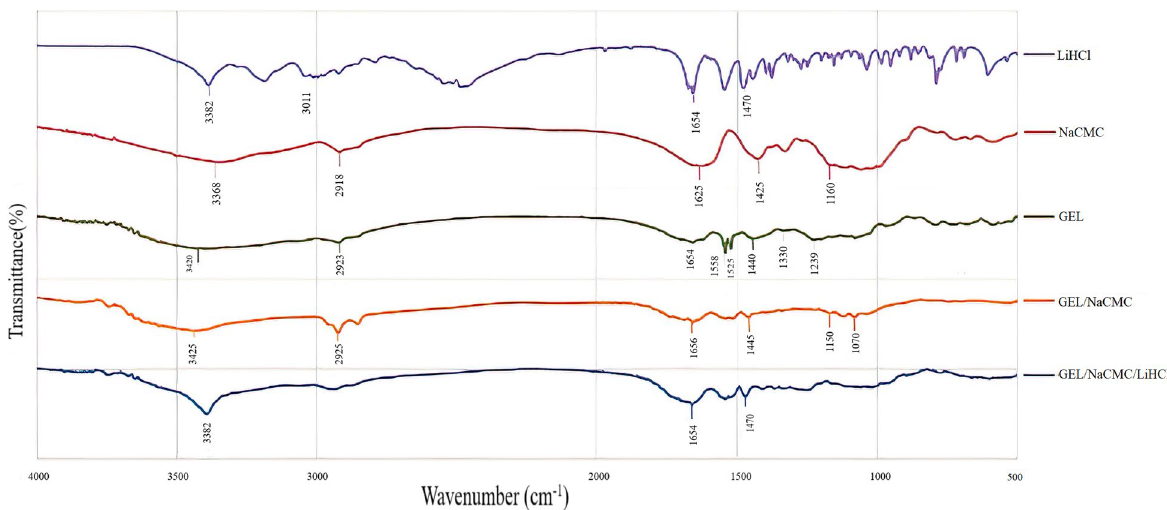
Fig. 6 FTIR spectra of the LidoHCL, NaCMC, GEL/NaCMC DMN, and drug-loaded DMN